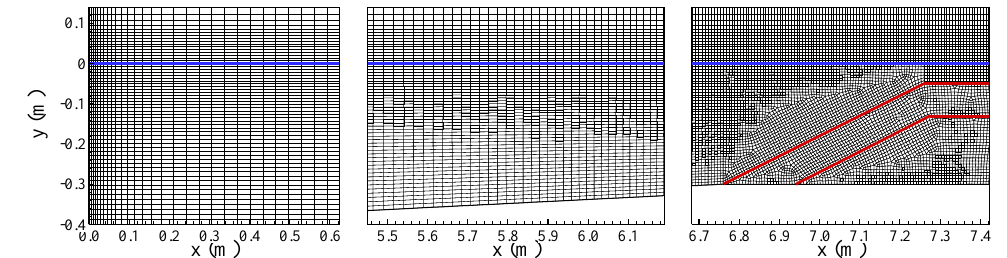
Figure 15. Details of the mesh near the wave-maker, along the flume (above the ramp) and in the proximity of the low-crested permeable breakwater. The blue line indicates the SWL and the red ones the limits of the porous layers.